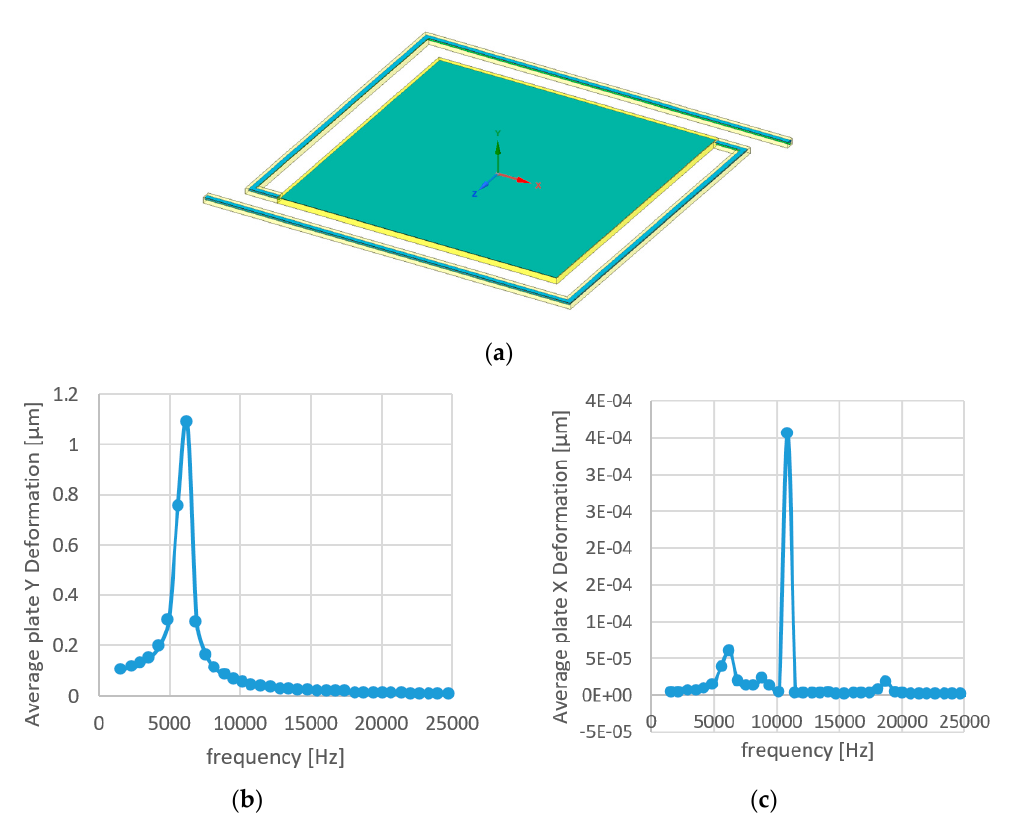
Figure 10. ( a ) The mechanical model, assuming vacuum and fixed support on the arm edges. ( b , c ) Average deformation of the plate versus frequency for applied force of F = (0, − 0.1 µ N,0) on the stage in Y ( b ) and X ( b ) directions.